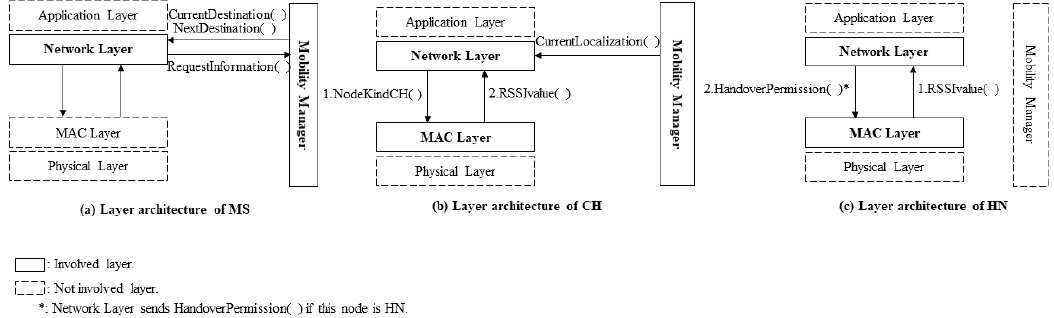
Figure 7. Involved layers in CLR-MSPH. ( a ) The layered architecture of the MS; ( b ) The layered architecture of a CH; ( c ) Layered architecture of an HN.